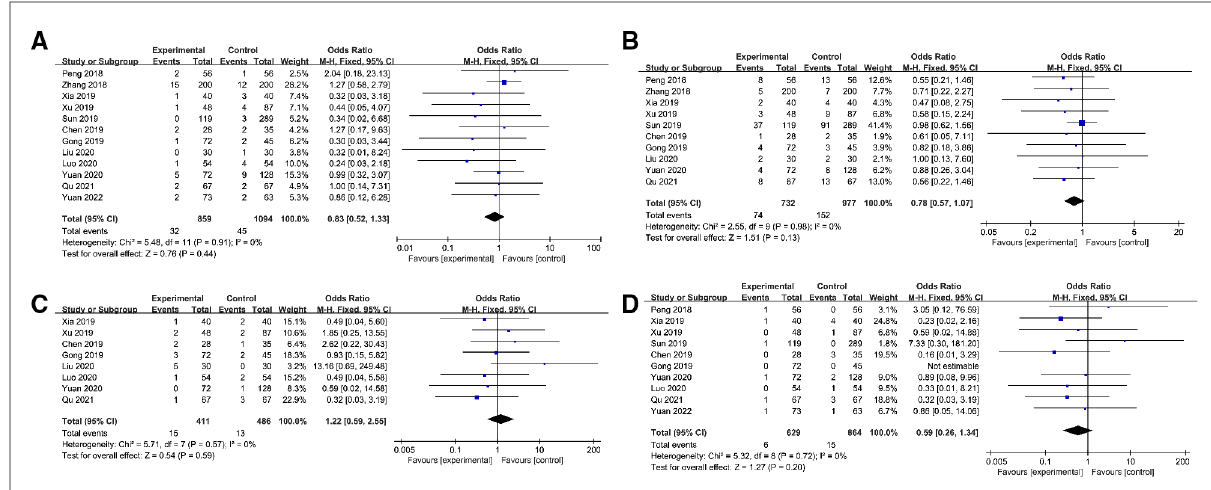
FIGURE 3 Forest plot of the meta-analysis. Experimental group: ETCA group; Control group: COT group. ( A ) hoarseness; ( B ) hypocalcemia; ( C ) hematoma; ( D ) infection.